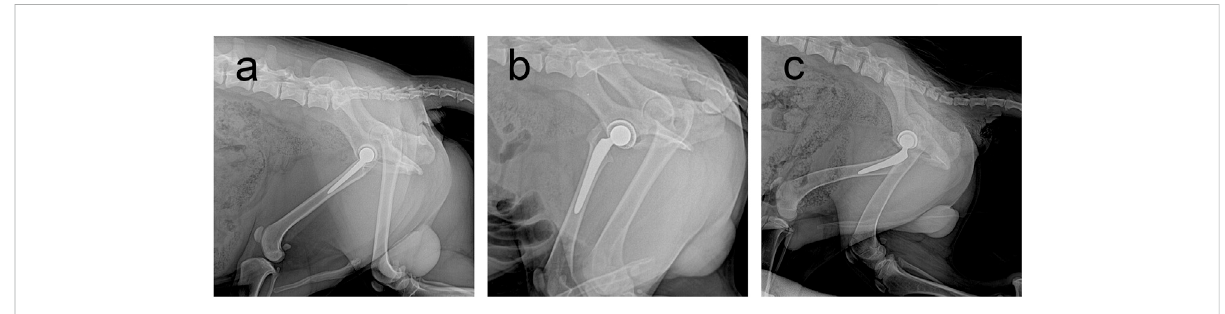
FIGURE 4 Follow-up X-rays of prostheses of three materials at 6 months postoperatively. Prosthesis can be seen in a good position, with no obvious loosening and dislocation and other performance. (A) Sintered porous titanium alloy acetabular cup groups; (B) 3D-printed porous titanium alloy group; (C) HA-coated titanium alloy acetabular cup group.